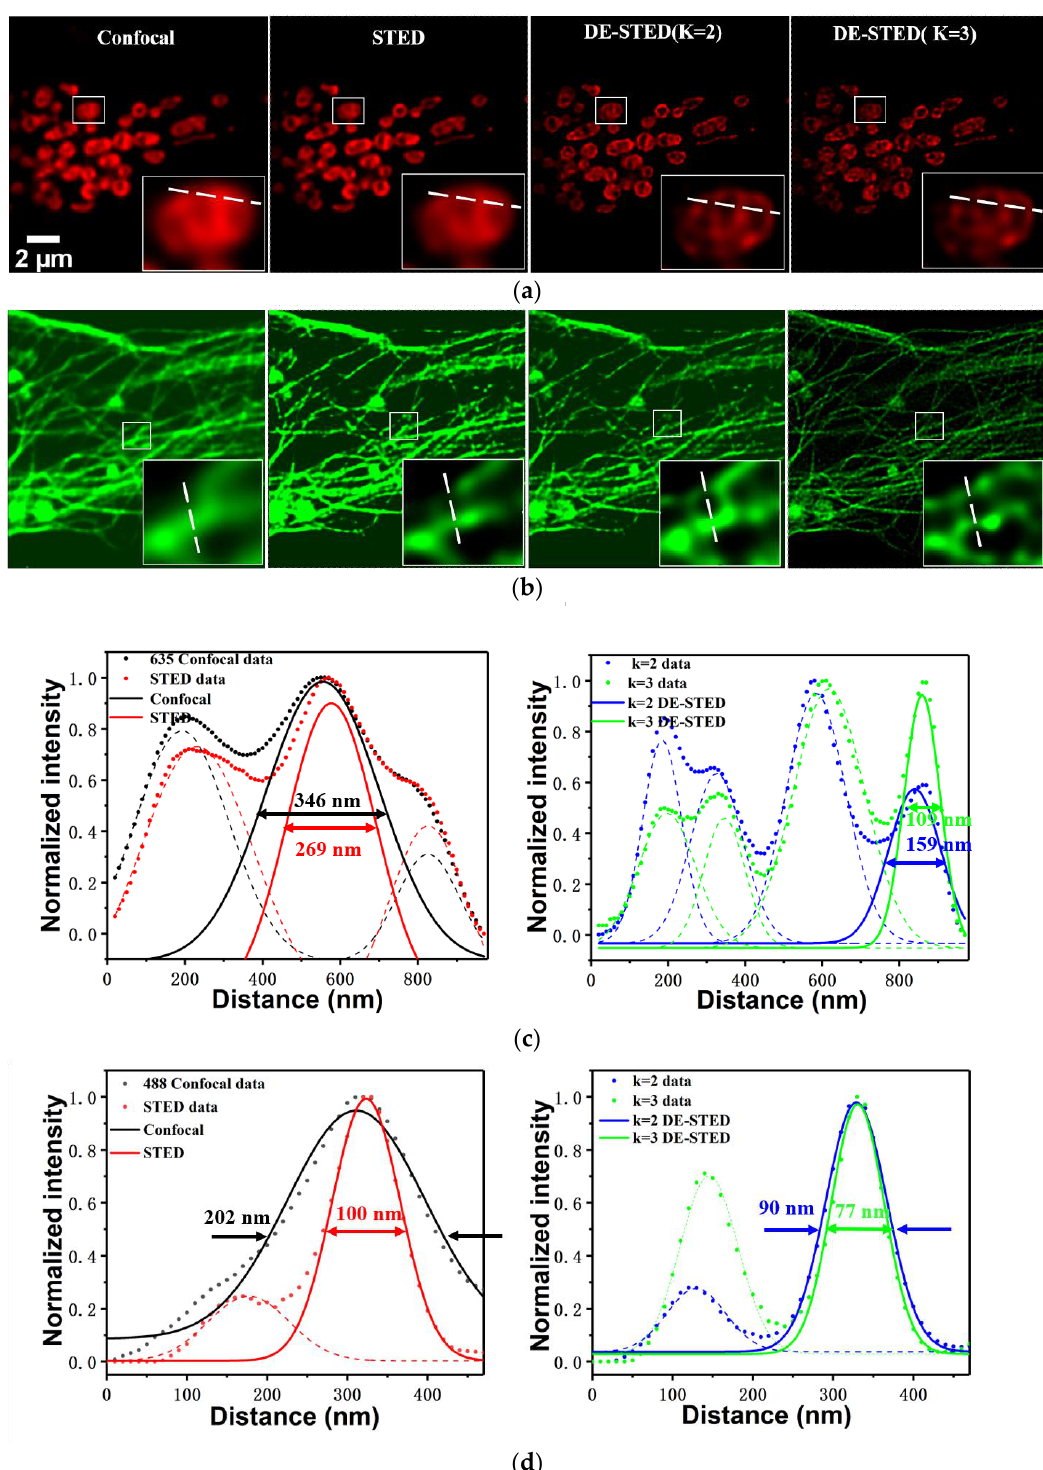
Figure 6. Two-color DE-STED results from the same living U2OS cell. ( a ) Confocal and STED (0.8 mW) images of mitochondria, and DE-STED images with k values of 2 and 3. ( b ) Confocal and STED (0.8 mW) images of tubulin, and DE-STED images with the values of 2 and 3. ( c ) Normalized intensity profiles along the white dashed lines in ( a ) for confocal (black curve), STED (red curve) image, and k = 2 (blue curve) and k = 3 (green curve) DE-STED image. ( d ) Normalized intensity profiles along the white dashed lines in ( b ) for confocal (black curve), STED (red curve) image, and k = 2 (blue curve) and k = 3 (green curve) DE-STED image. Scale bar: 2 μm.